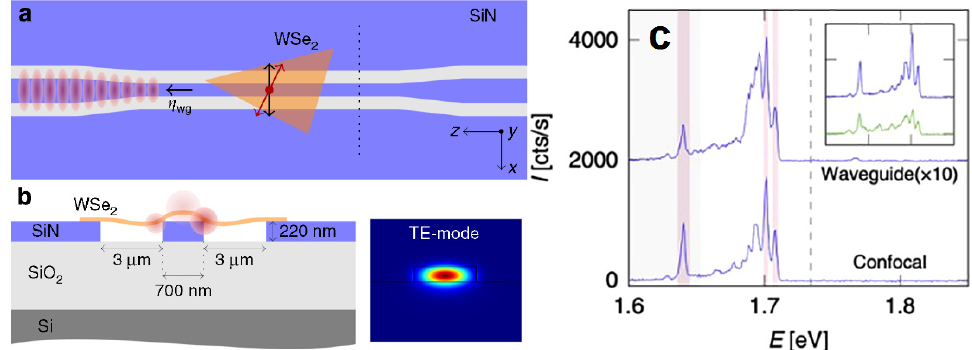
Figure 14. Integrated WSe 2 quantum emitters. ( a ) Top view of the device. ( b ) Cross-section of the sample. ( c ) Emission from a confocal (bottom) and a waveguide-coupled SPE (top) illustrated in ( a ) [69].